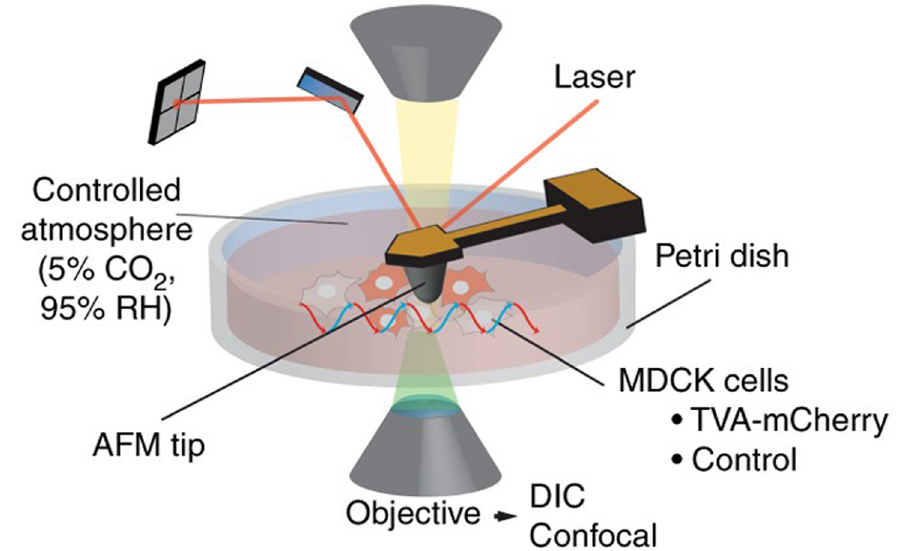
Figure 1. Combined force distance-based atomic force microscope and confocal microscopy for life science used to study the binding effects of a single virus onto the surface of a mammalian cell. Reprinted from the work in